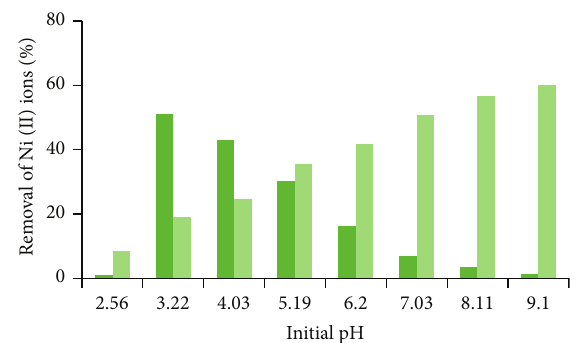
Figure 9: Desorption and recycling of Ni (II) ions onto